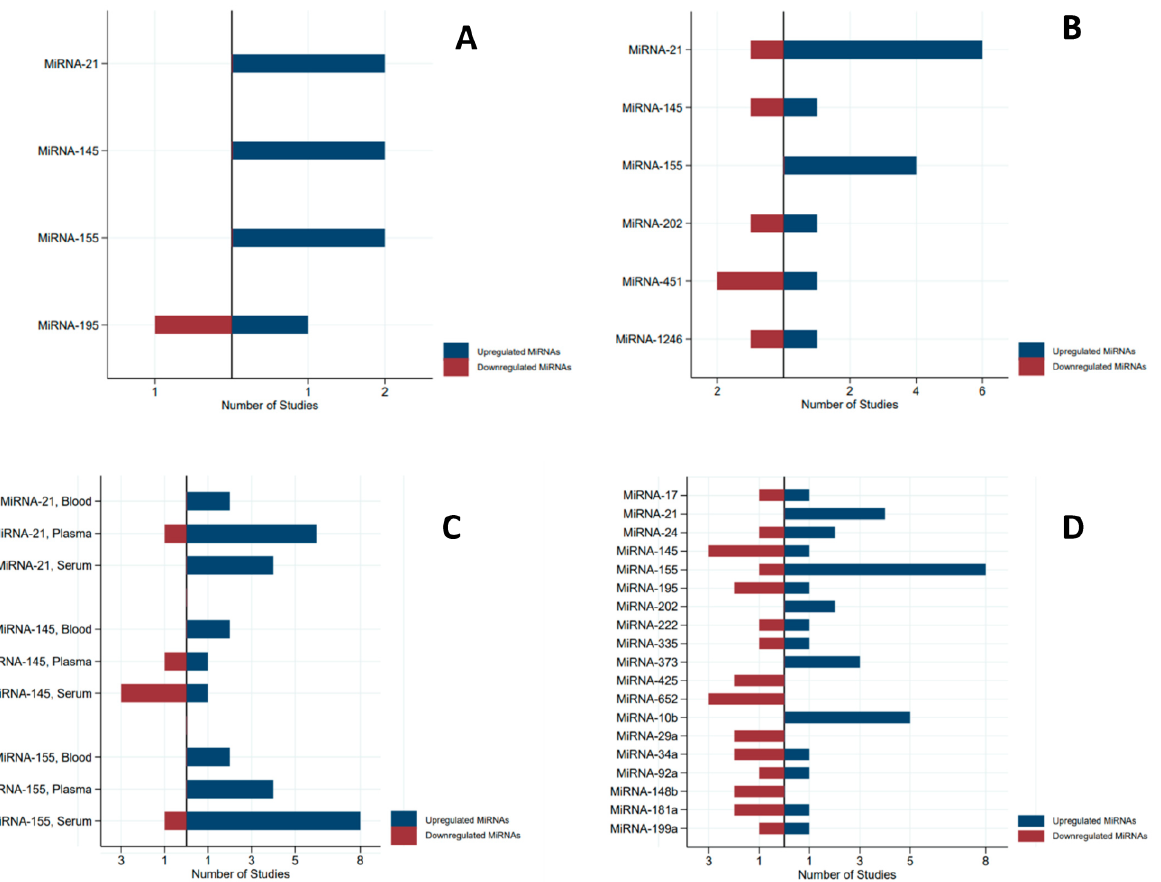
Figure 2. Pyramidal graph of the direction of miRNA expression (microRNA concentration in breast cancer cases versus controls) by type of specimens (only microRNAs that were analysed in two or more independent studies). ( A ) = whole blood, ( B ) = plasma; ( C ) = all specimens; ( D )= serum.